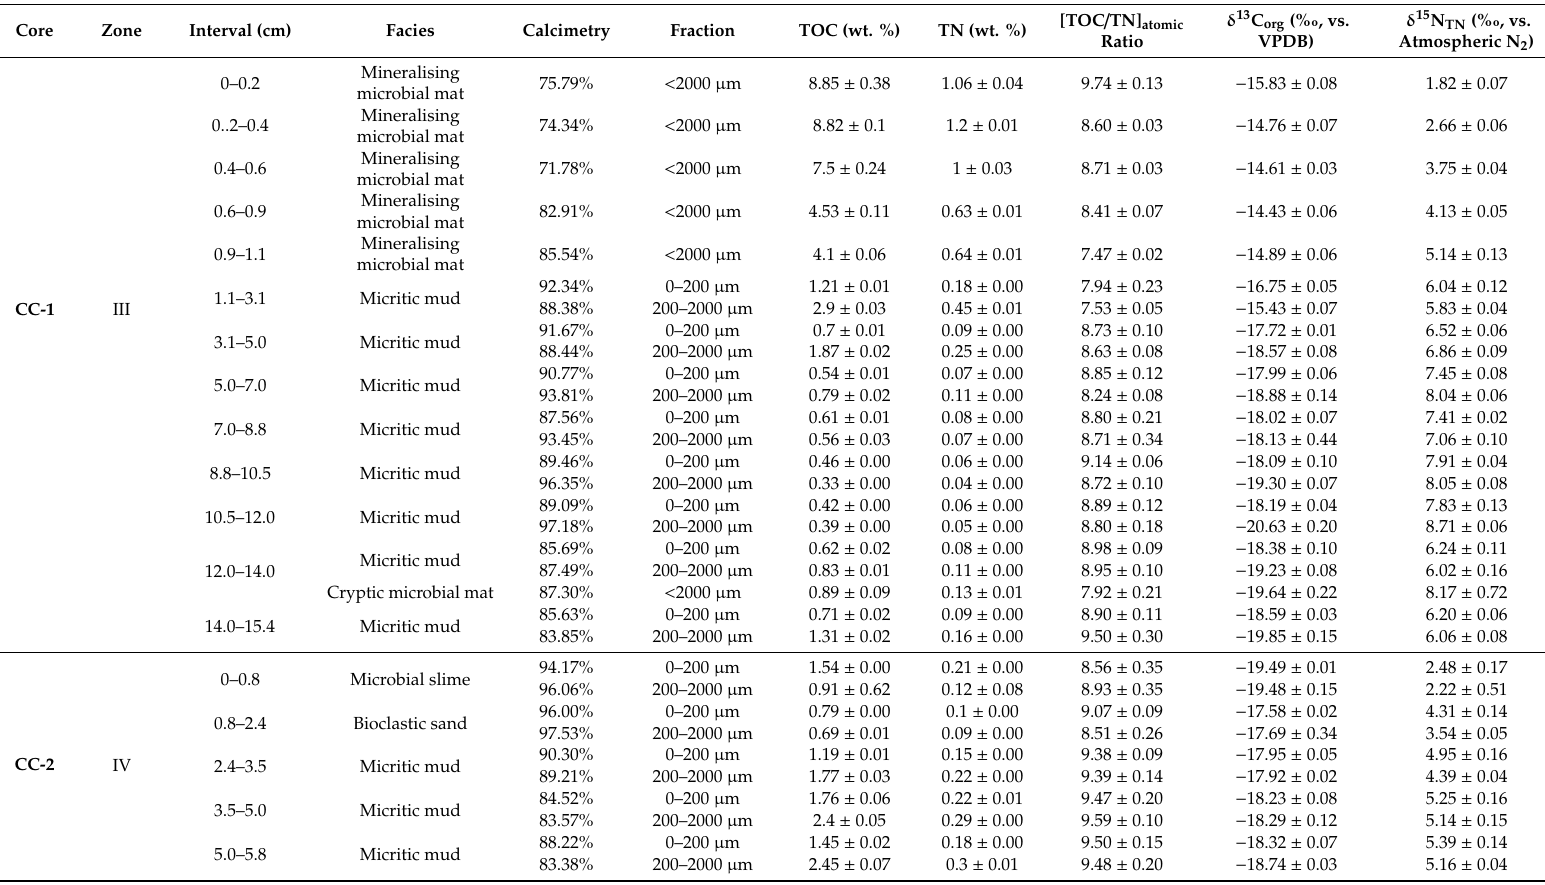
Table 2. Elemental (TOC, TN and [C / N] atomic ratio) and isotopic ( δ 13 C org and δ 15 N TN ) measurements of the four sedimentary cores. (Please refer to Figure 2 for location and Figure 4 for diagram